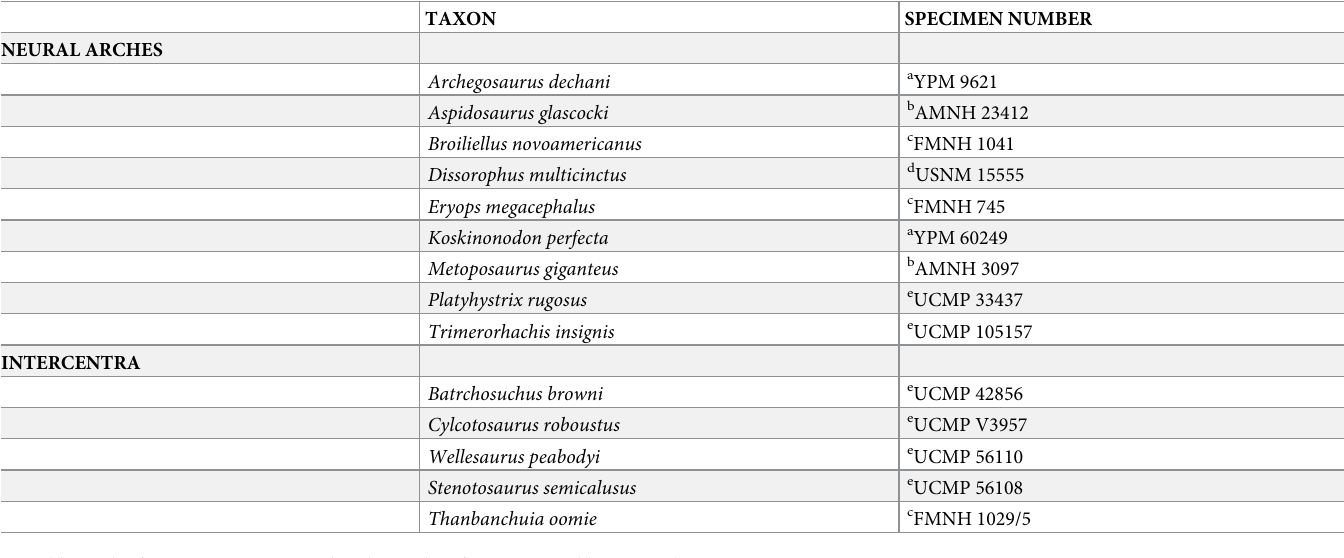
Table 1. Museums used in this